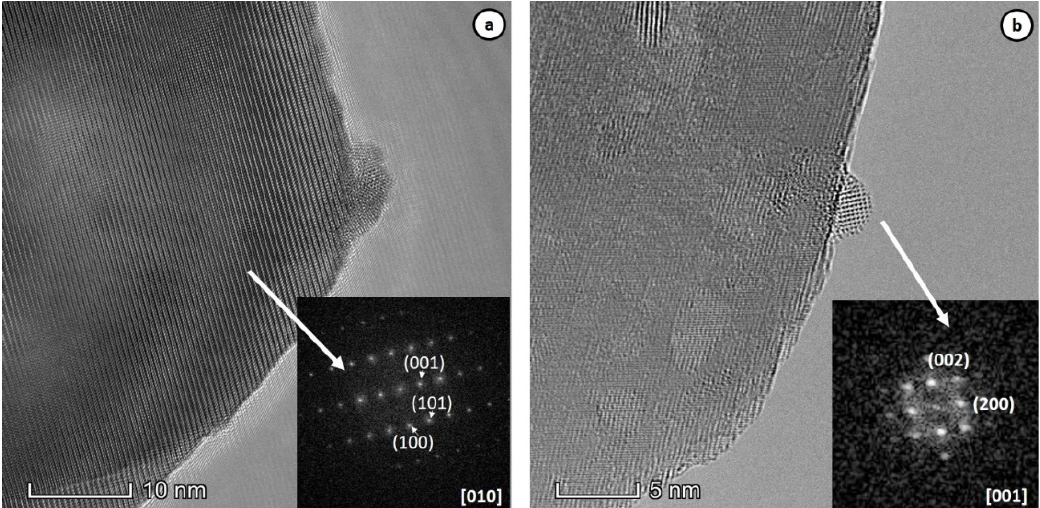
Figure 9. HRTEM images and the corresponding digital diffraction patterns (DDP) of the ZnO:Ce 2% sample where the wurtzite structure of ZnO ( a ) and the fluorite structure present in a supported Ce x Zn 1-x O y nanoparticle ( b ) can be identified.